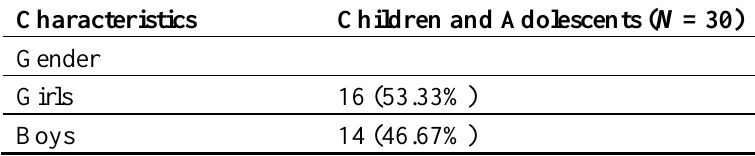
Table 3. Characteristics of the participating children and